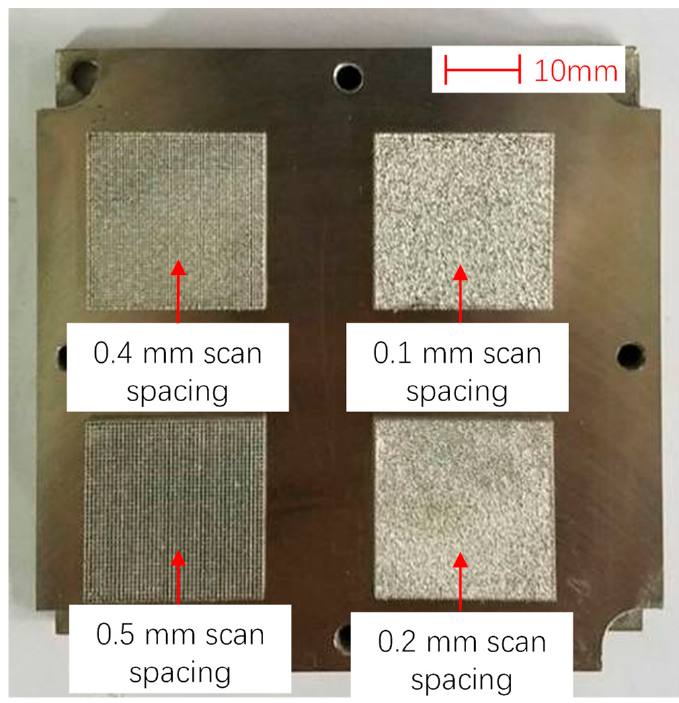
Figure 4. Grid structures formed using different scan spacings.